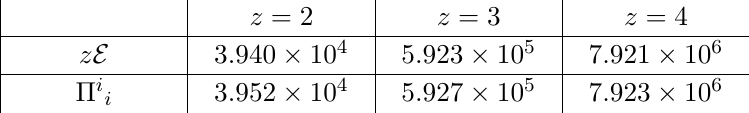
Table 1 . The numerical values of z E and Π i i at r → ∞